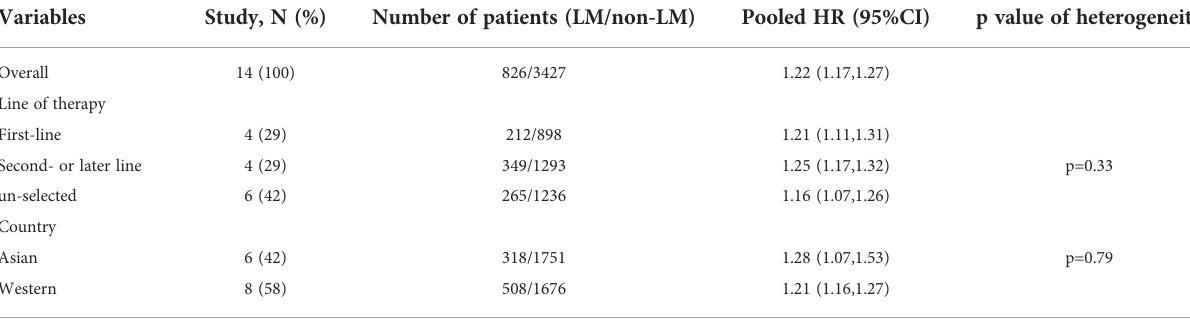
TABLE 4 Analyses of pooled hazard ratios for OS outcomes by subgroup in clinical